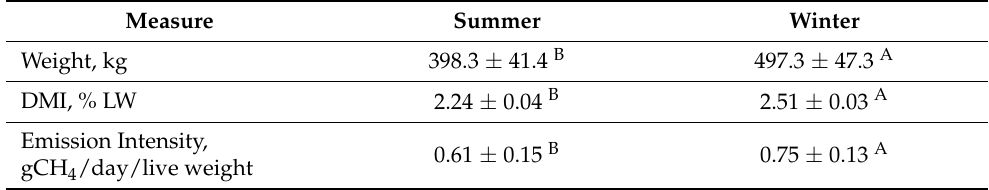
Table 3. Seasonal average values (summer and winter) recorded during the trial, expressed as mean ± s.d.